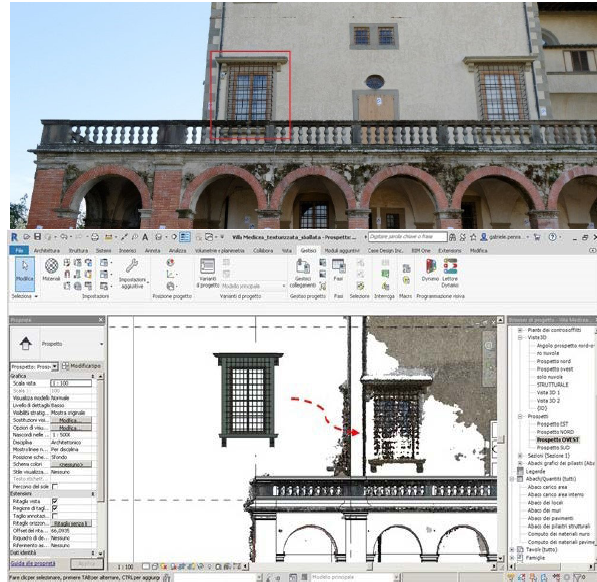
Figure 5. An architectural component (historic window) generated with point cloud retracing (Scan-to-BIM approach), and in the complete model by comparison with the point cloud (HBIM approach).